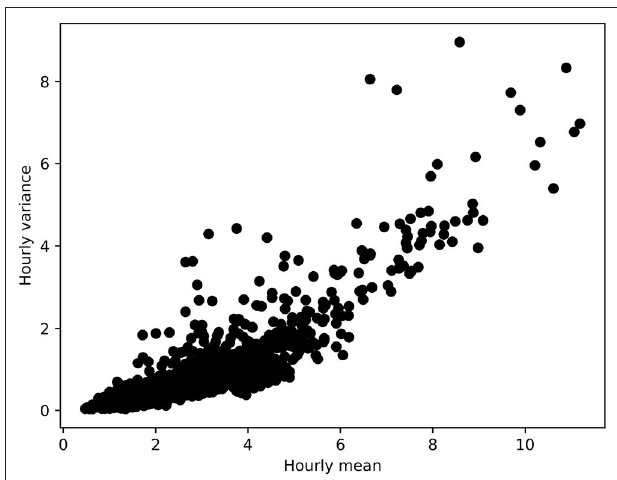
FIGURE 5 | Scatter plot of hourly variance against hourly mean of the high-frequency wind speed